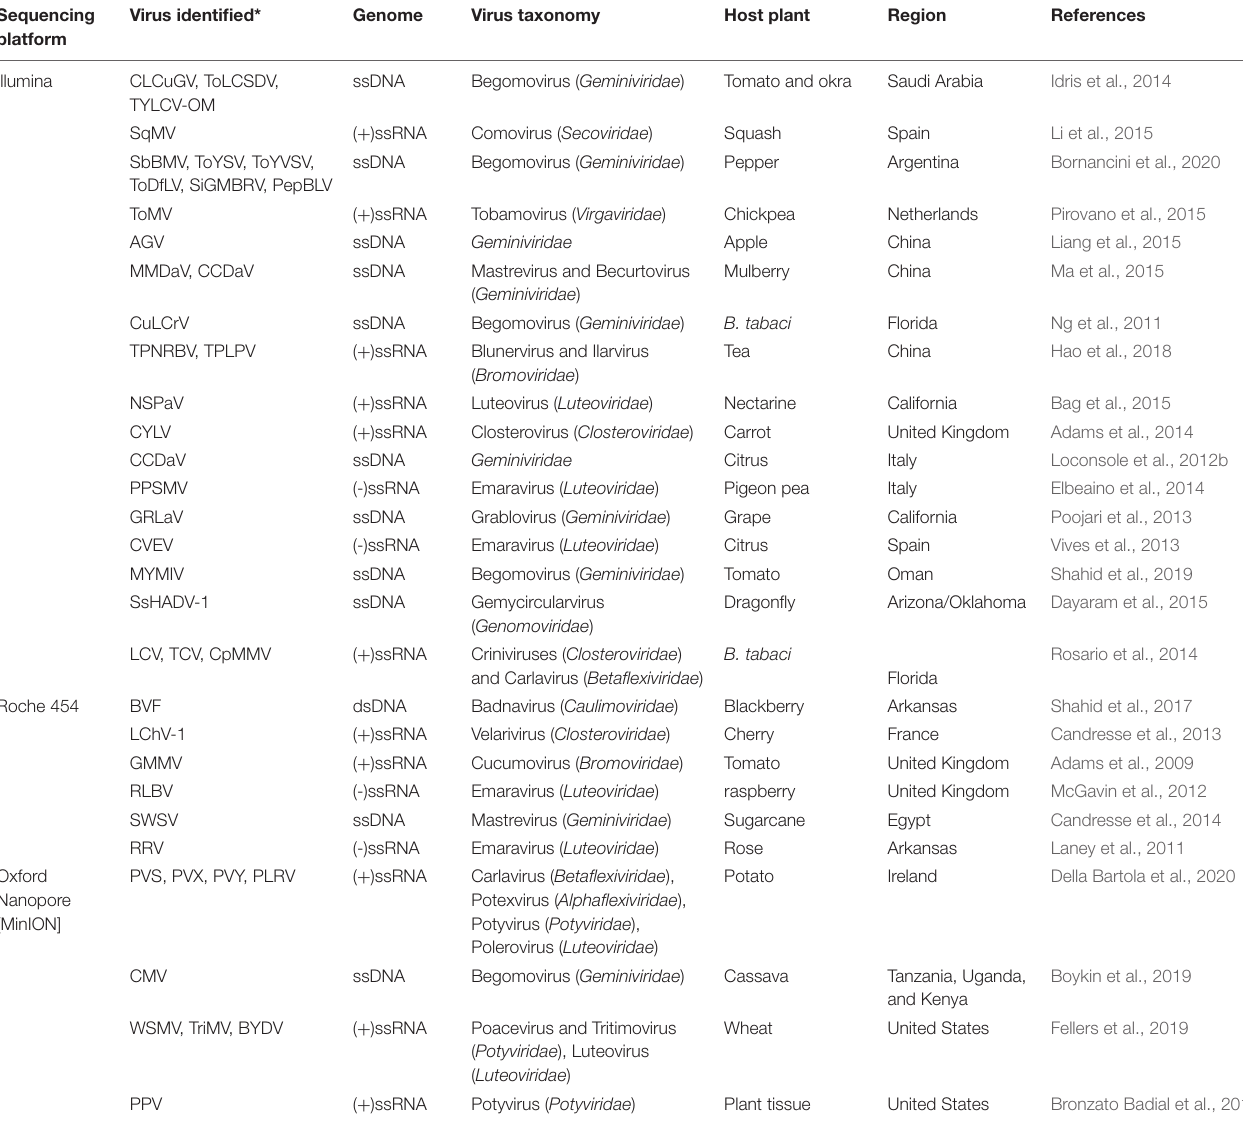
TABLE 1 | Next-generation sequencing (NGS)-mediated discovery of selected different plant infecting viruses. Sequencing